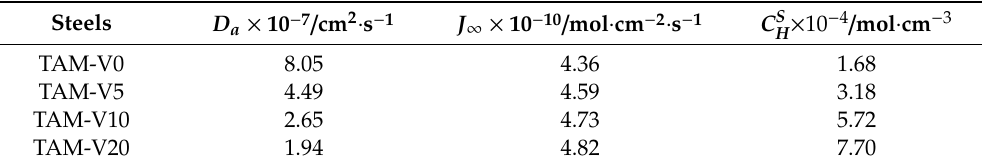
Table 4. Calculated hydrogen permeation